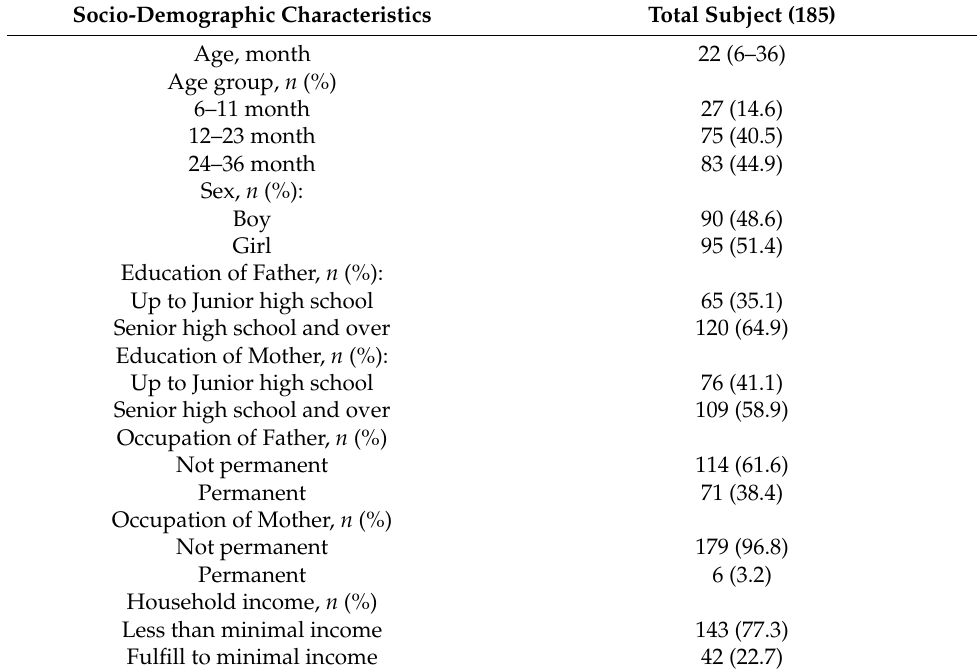
Table 1. Socio-demographic characteristics of children aged 6–36 months. Socio-Demographic Characteristics